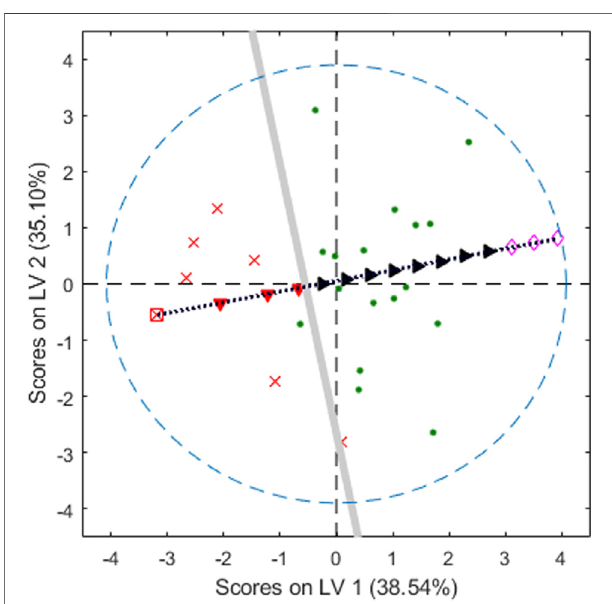
FIGURE6| Plasticpellets.Secondvs. fi rstlatentvariables.Greenpoints for adequate objects, red crosses, and the square, for the poor ones. The thicker grey line is the decision line with 93% sensitivity and speci fi city and the black dotted line is the direction of ‘ repairing ’ the poor object to become adequate . Red fi lled downward-pointing triangles for poor, black fi lled right- pointing triangles for adequate. Empty rhombuses are outside the domain. The blue dashed line is the 95% con fi dence limit of the PLSbox inside the latent